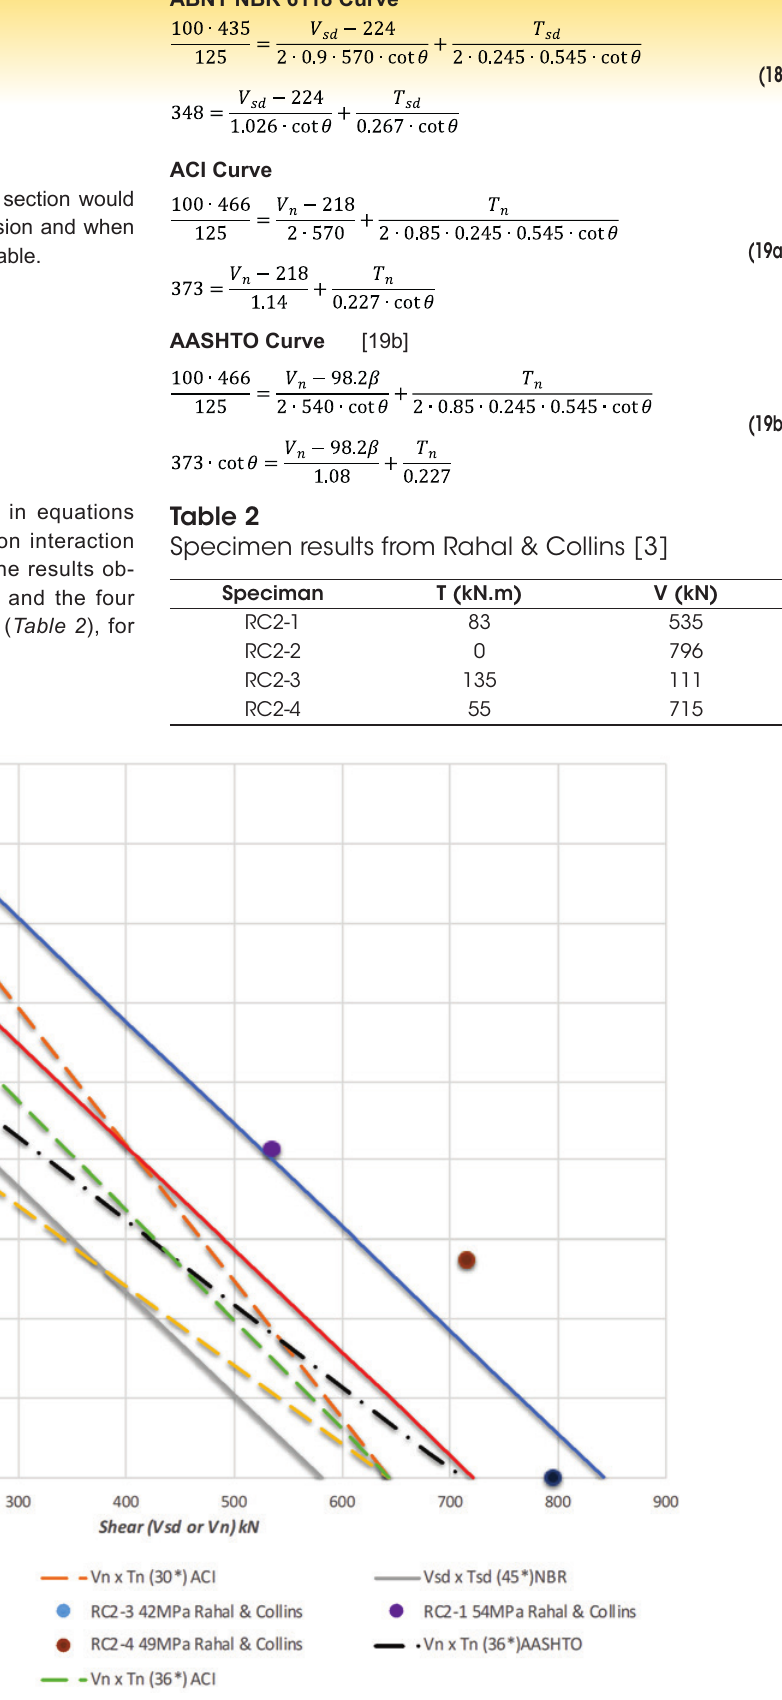
Figure 6 Shear-torsion interaction diagrams comparing ACI, AASTHO, ABNT NBR 6118 and